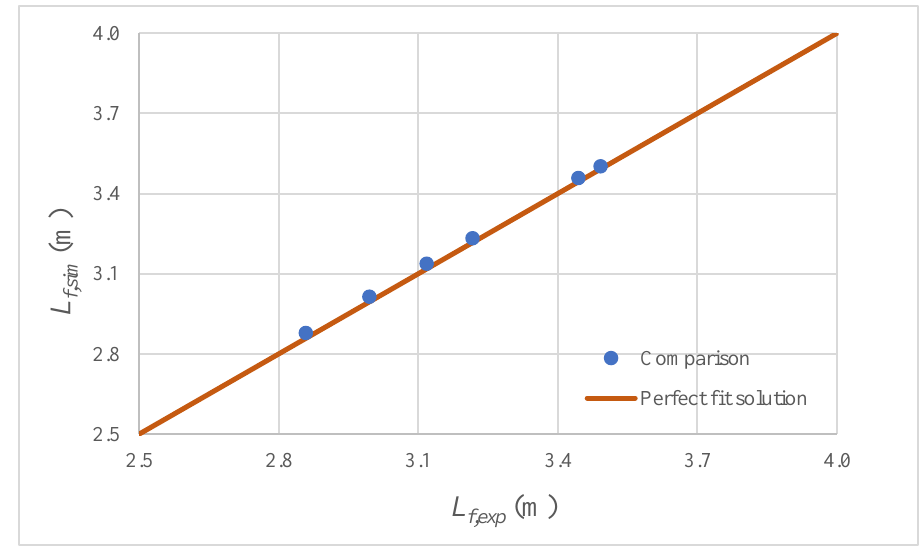
Figure 10. Comparison between experimental and simulated final water column lengths .